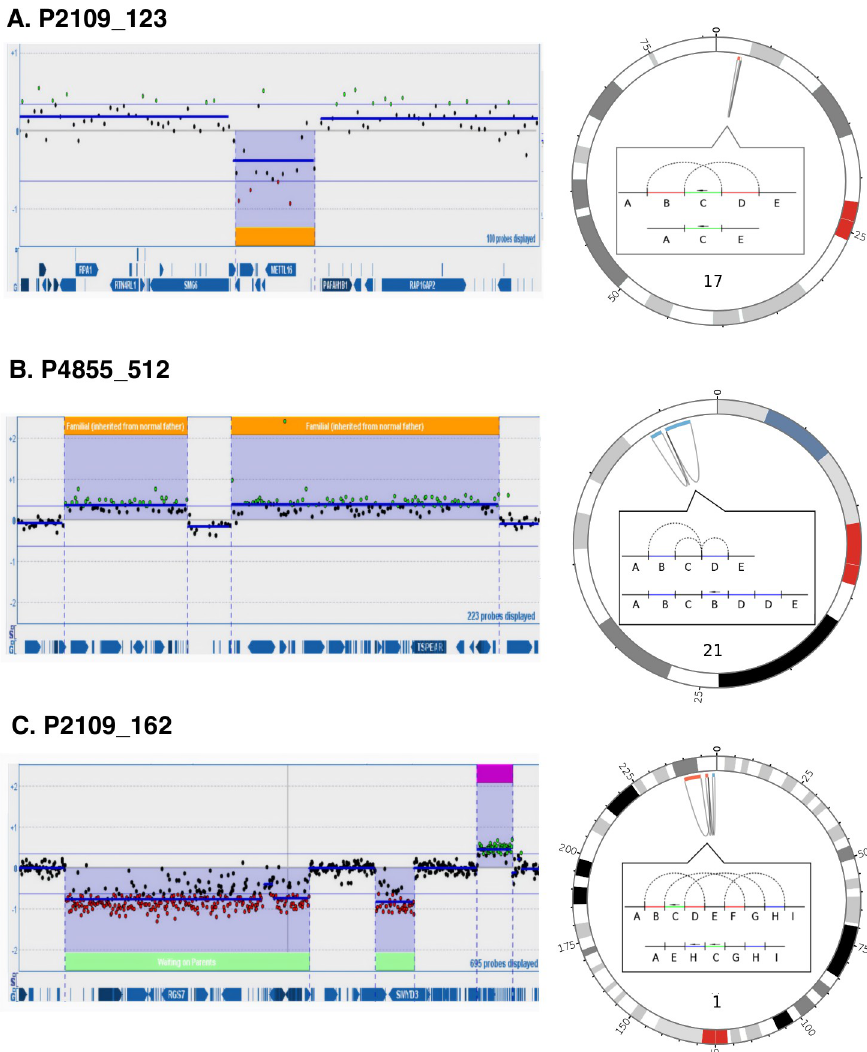
Fig 1. Schematic illustrations of WGS results from three cases representing the three complex CNVs categories: (1) deletions only, (2) duplications only, and (3) deletions and duplications. (A) Case P2109_123 with DEL-INV-DEL, (B) Case P4855_512 with DUP-N-DUP, and (C) Case P2109_162 with a complex rearrangement consisting of inversions, deletions and duplications (DEL-INV-DEL-N-DEL-N-DUP). For case P2109_123 the array- CGH analysis only identified a single deletion and the complex rearrangement was only seen by the WGS analysis. For all the array-CGH results are visualized as a plot seen on the left. The individual dots represent specific oligonucleotide probes and are indicated as black (normal copy number), green (copy number gain), and red (copy number loss) compared to a reference sample. Genes are shown as blue arrows below. On right side the WGS result is shown, illustrated as a Circos plots and within the Circos plots as linear plot with copy number status indicated as black (normal copy number), blue (copy number gain), or red (copy number loss) and inverted segments marked with an arrow. Linked reads showing connections between chromosomal BPs are illustrated as dashed